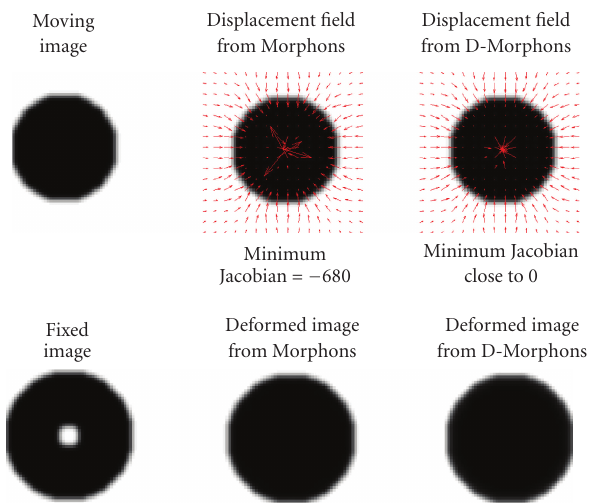
Figure 5: Results of the registration between 2 images using Morphons and D-Morphons registrations, illustrating the case where a structure (i.e., the bright hole at the center of the fixed image) is missing in the moving image. Both methods lead to deformed images very similar to the fixed image except for the central bright part (because it wasnot present inthe moving image). The di ff eomorphic method produced very low but still positive Jacobian values (( J ) close to 0) in the center of the disk. Given that the field is defined on the pixel grid of the fixed image, this means that the surface of the central bright part (which disappears in the moving image) corresponds, as expected, almost to a singular point in the moving image. The conventionalmethod, however, produced highly negative Jacobians in the central part, leading to the creation of areas that are “mirrors” of areas in the other